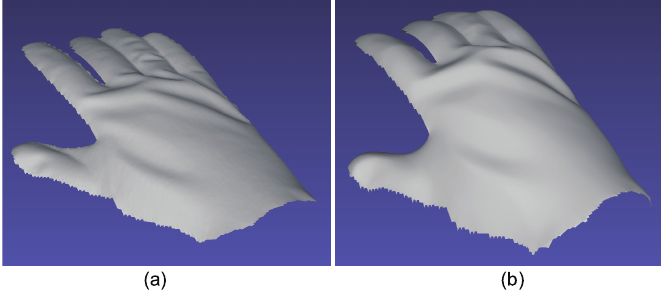
Figure 26. The results for hand with glove. Estimated albedo [pose 1] is shown, which is smooth enough.